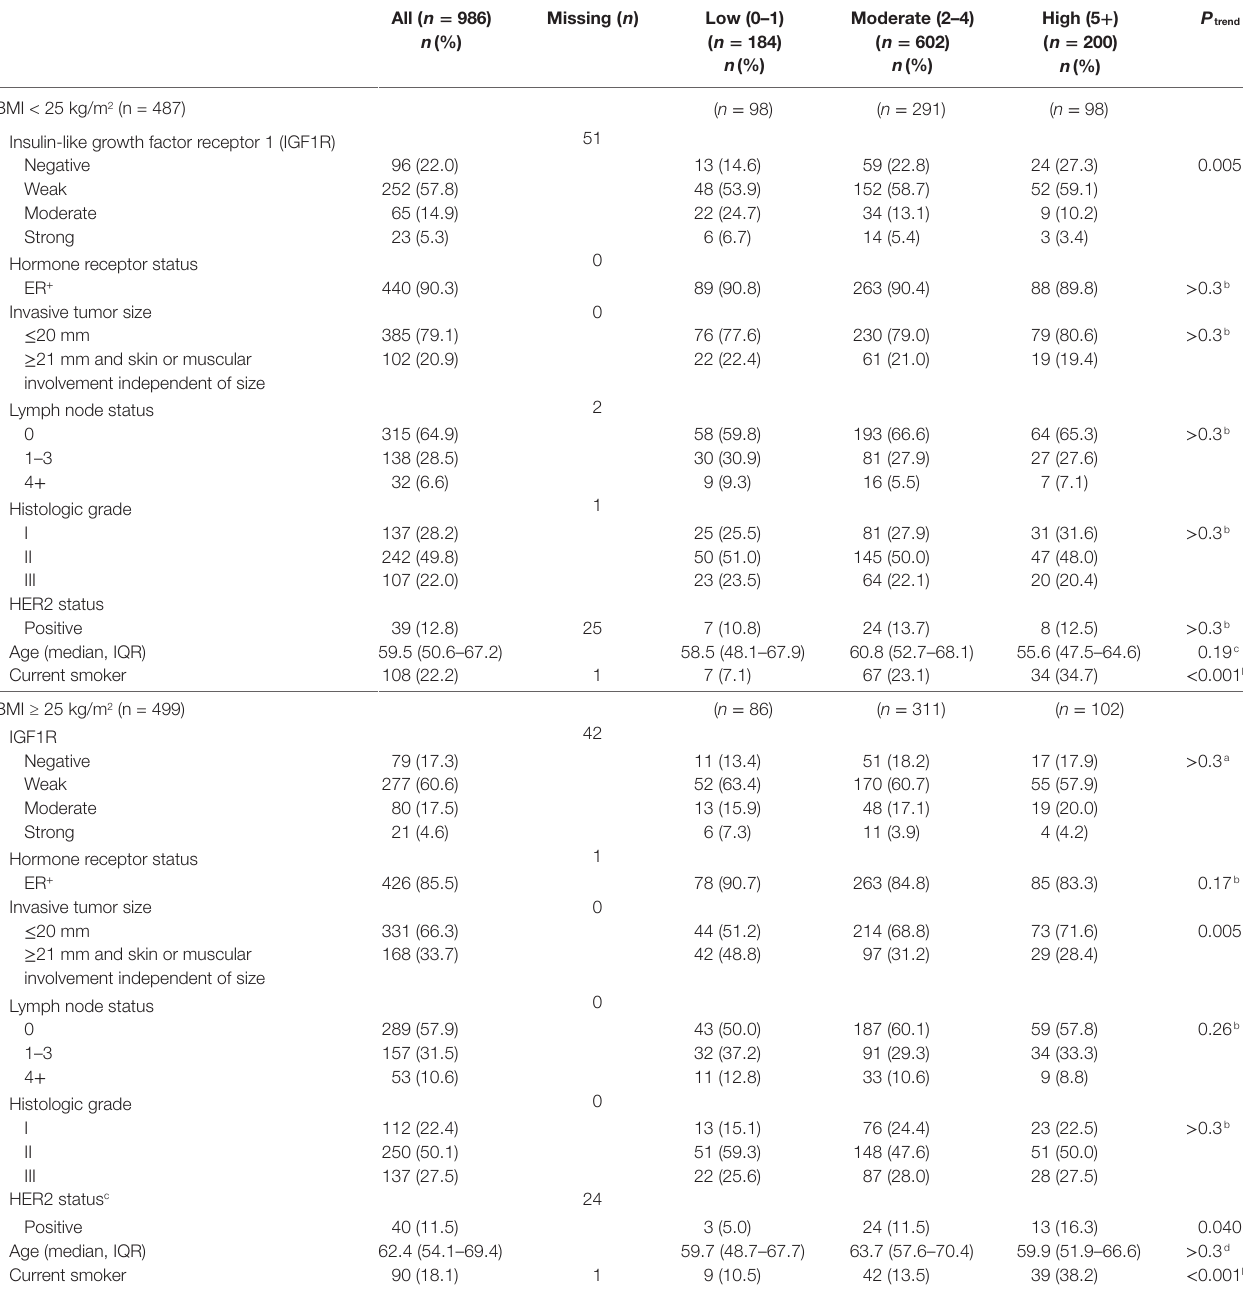
Information about BMI was missing for 28 patients. a Partial correlation test adjusted for time between surgery and staining. b Linear-by-linear association test. c HER2 status was only available for patients included as of November 2005. d Jonckheere-Terpstra test. IQR, interquartile range.